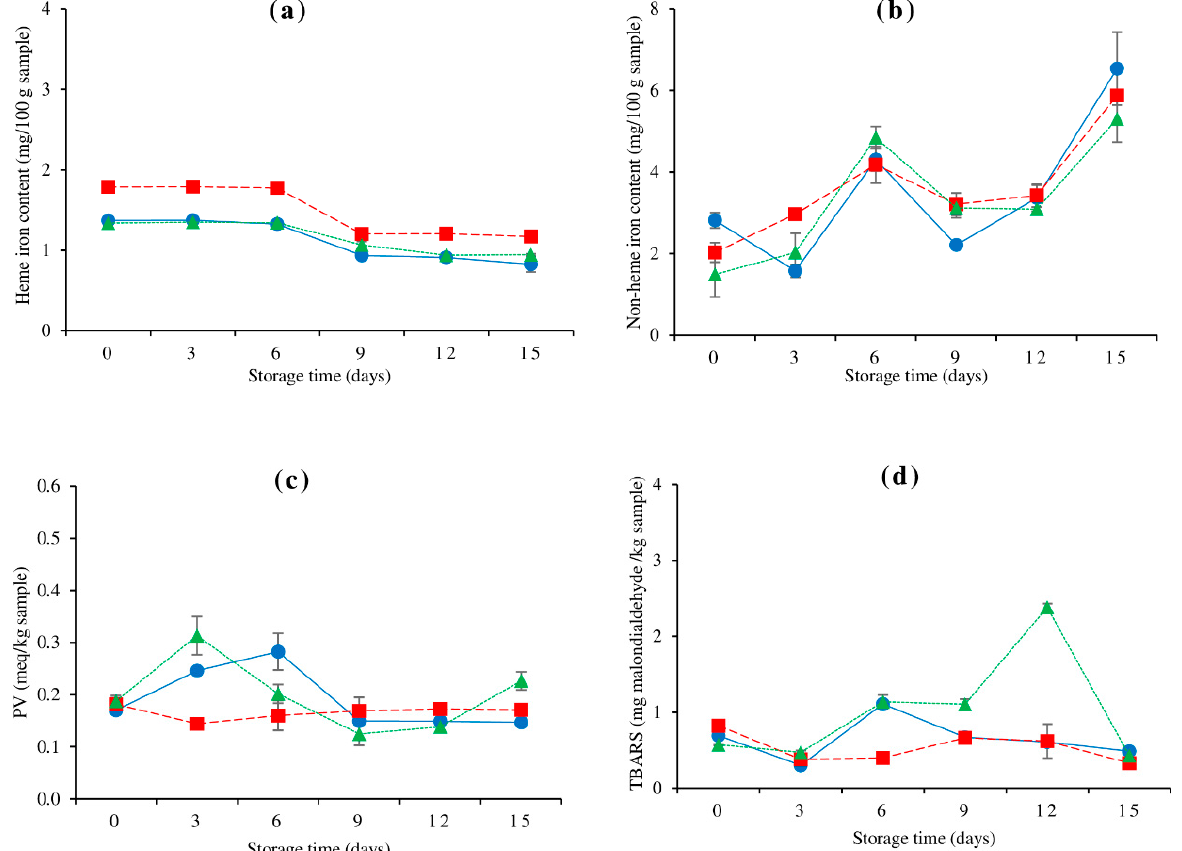
Figure 2. Changes in heme iron ( a ), non-heme iron ( b ), peroxide value (PV) ( c ), and thiobarbituric acid reactive substances (TBARS) ( d ) of farmed hybrid catfish dorsal muscle ( ⎯ ● ⎯ ), lateral line (--- ■ ---), and ventral muscle ( … ▲ … ) during 15 days of refrigerated storage. The bars indicate standard deviation from triplicate determinations.